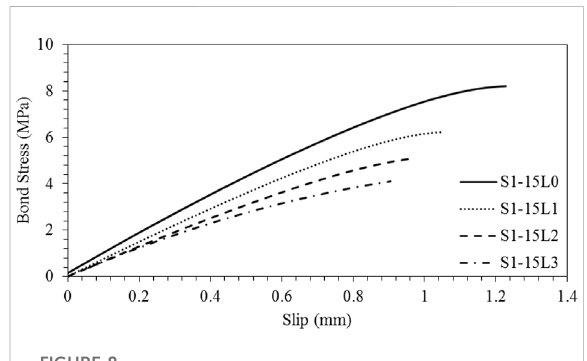
FIGURE 8 Relation between bond stress and slip for S1 strip and bond length of 150 mm.